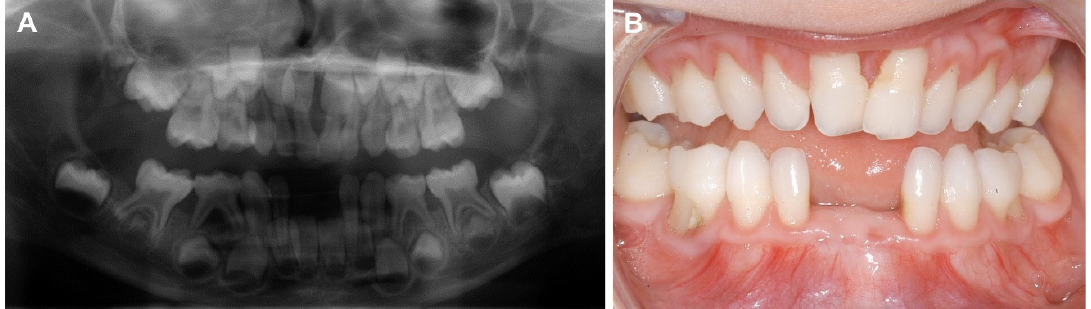
Figure 4. Radiological and clinical dental investigation. ( A ) The panoramic X-ray at age five years revealed extensive alveolar bone loss on teeth 82, 83, and 84 with furcation involvement in the latter. Teeth 71 and 81 were lost due to periodontal bone loss at age four years. ( B ) Lack of attached gingiva is evident in the mandibula; the thin and fragile mucosa extends to the free gingival margin and the interdental papillae, which are normally keratinized and “thick”. Severe gingival recession up to 6mm was diagnosed in all teeth but numbers 75 and 85.